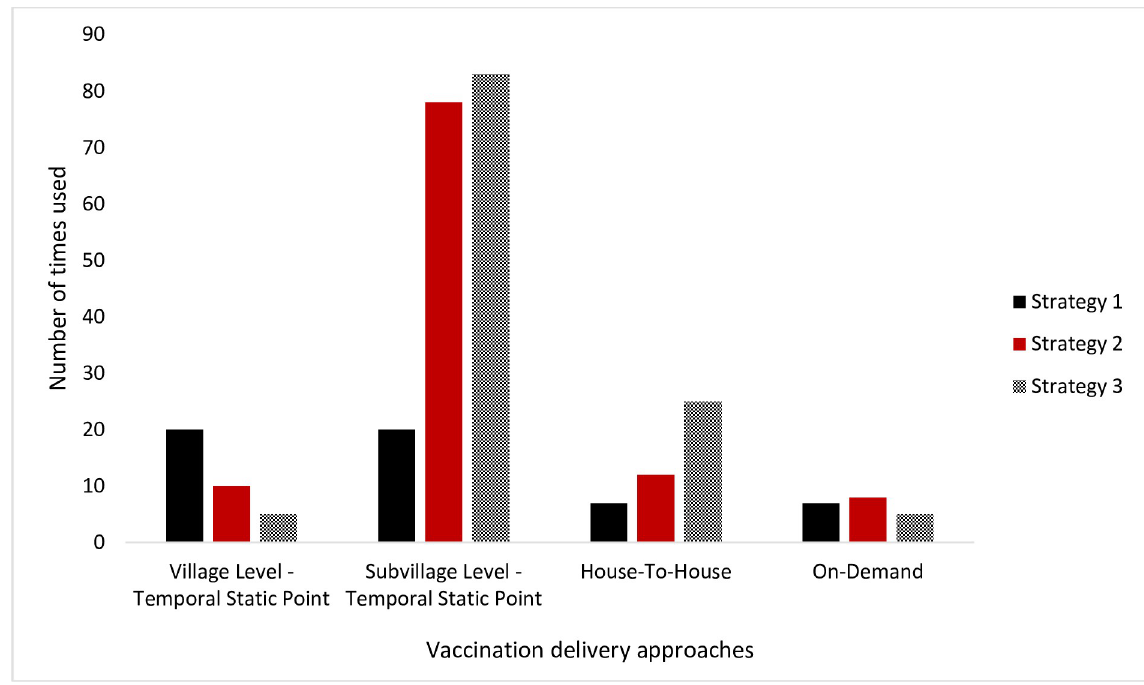
Fig 6. Use of vaccination delivery approaches by strategy team (totals for all three team per strategy).